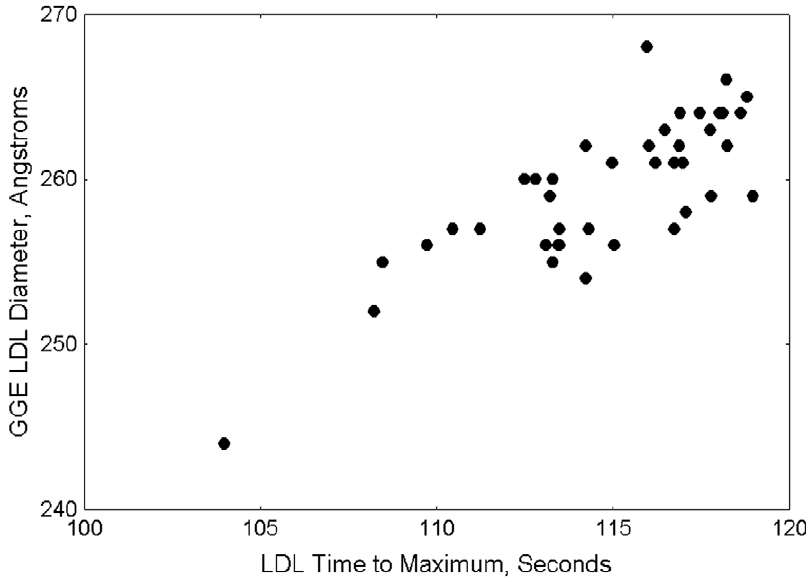
Figure 1. Typical relationship of average LDL particle size by gradient gel electrophoresis vs. VAP LDL peak maximum time density parameter; Pearson correlation coefficient, r=0.80, p , 10 2 6 .